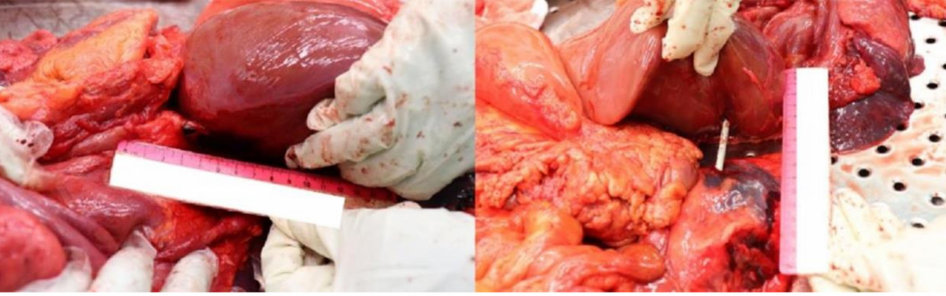
Figure 5. Thanks to the use of a probe, it has been possible to point out the projectile’s path through the ICV’s diaphragmatic ostium (left picture). The bullet also transfixed the infero-posterior surface of the liver, the right kidney’s capsule and its anterosuperior surface (right